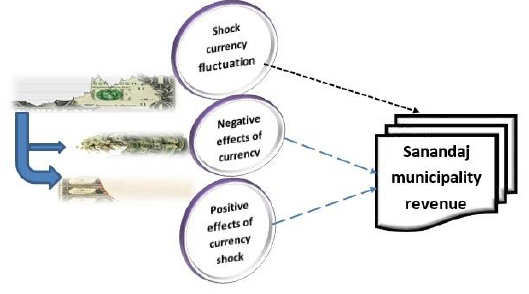
Figure 1. Conceptual Model